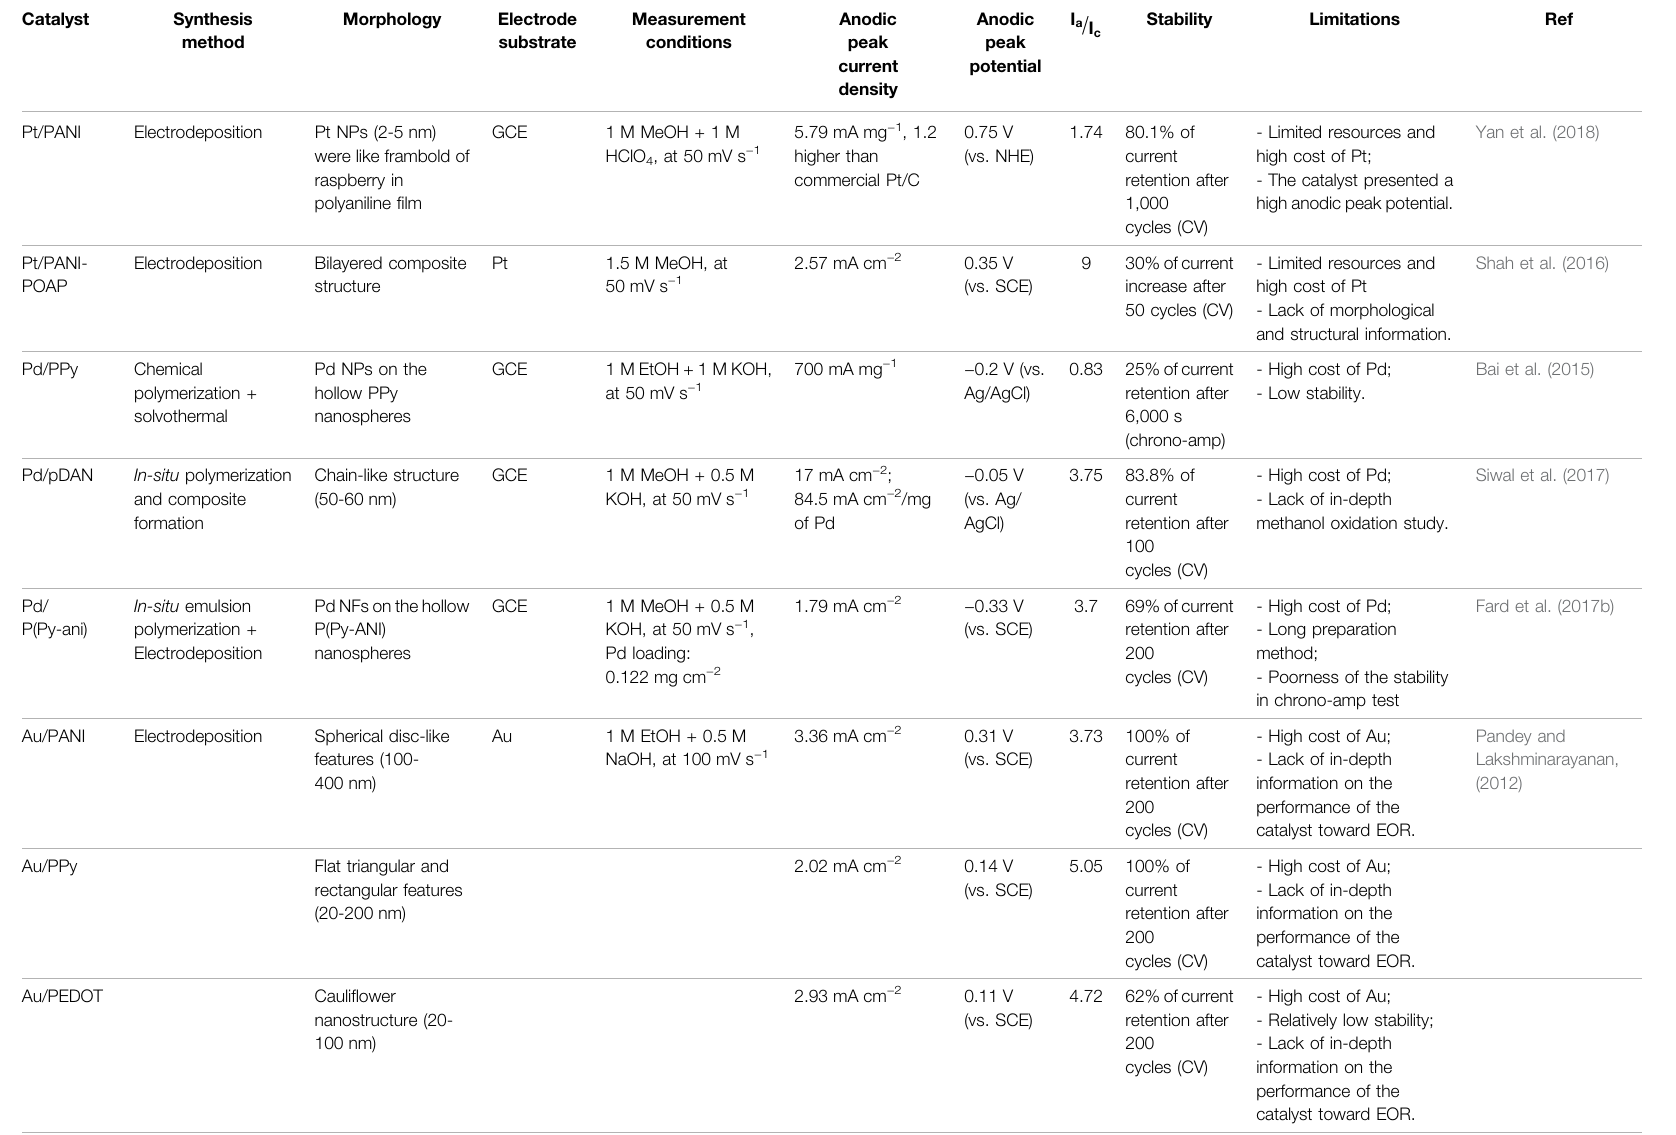
TABLE 2 | Electrochemical properties and electrocatalytic performances of monometallic-based conducting polymers catalyst applied for alcohol